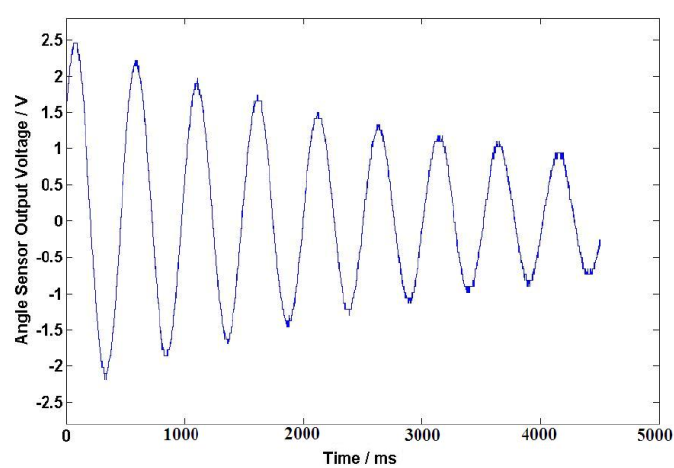
Figure 10. Output signals of angle sensor.